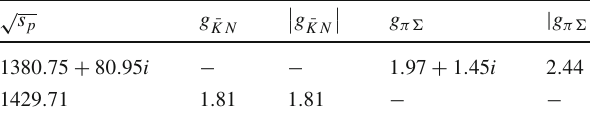
Fig. 9 Modulus squares of T ¯ amplitudes in single channel interaction Table 6 Pole positions and couplings in single channel interaction